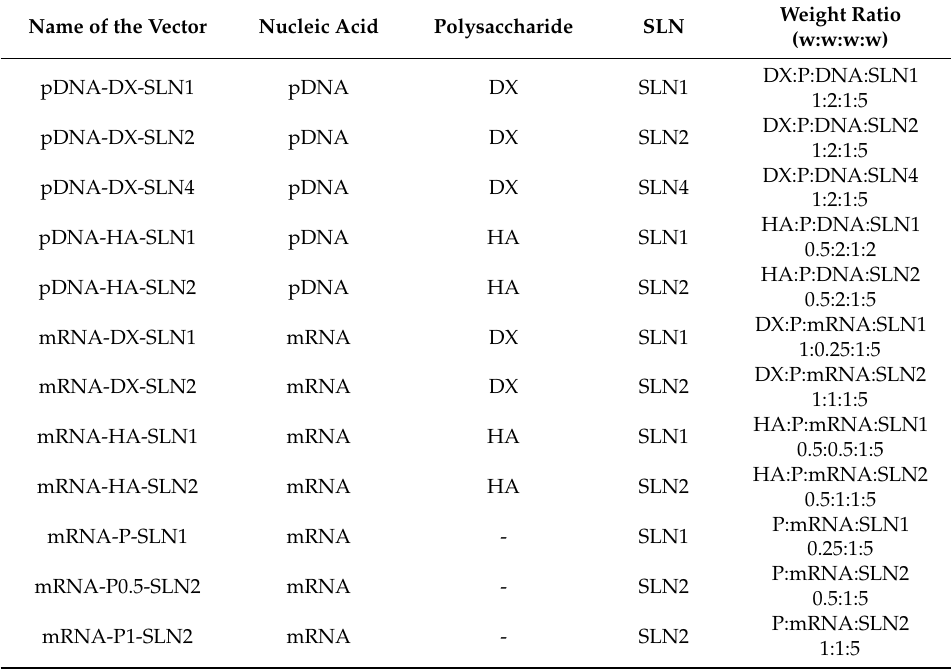
Table 4. Weight ratios of the